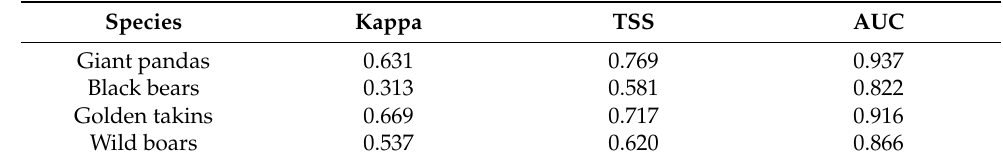
Table 1. Performances of the SDMs for giant pandas and sympatric competitive species. TSS: true skill statistic; AUC: area under the receiver operating characteristic curve.